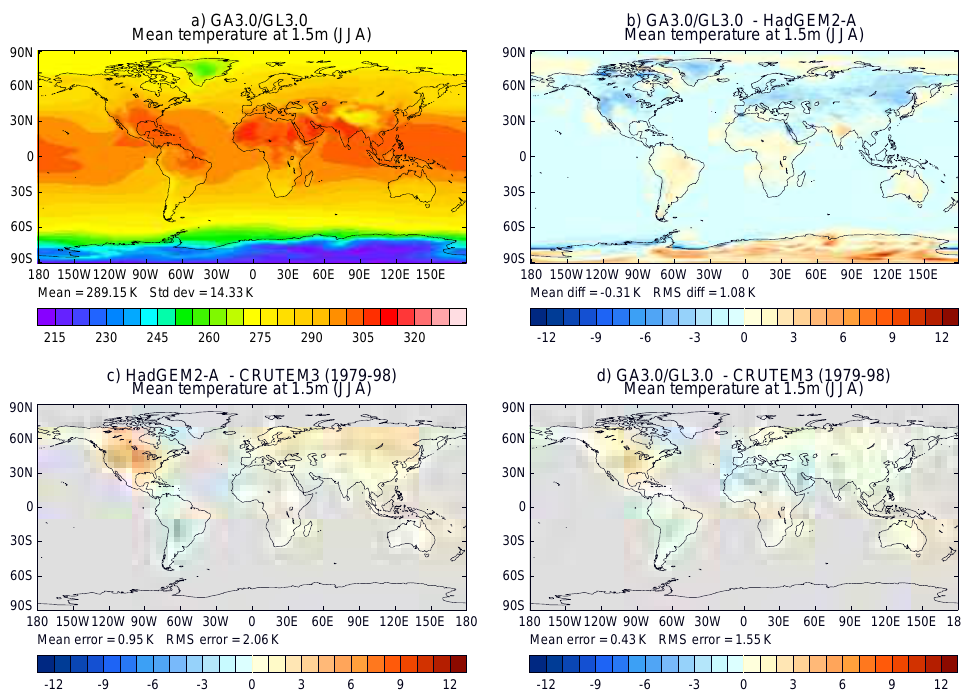
Fig. 3. Climatological 1.5m temperatures during JJA in a 30yr N96 atmosphere/land-only simulation. (a) full field from GA3.0/GL3.0, (b) model difference (GA3.0/GL3.0 minus HadGEM2-A), (c) HadGEM2-A bias (HadGEM2-A minus observations) and (d) GA3.0/GL3.0 bias (GA3.0/GL3.0 minus observations). Observations used are from CRUTEM3 (Brohan et al., 2006).